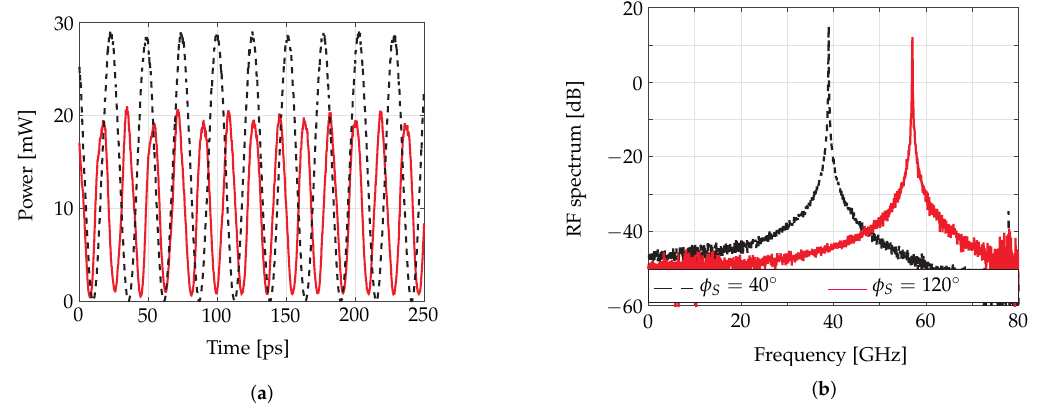
Figure 7. Two examples of sinusoidal the self-pulsation (SP) operation in Region (A) of Figure6a for I S = I M = 30mA for two different values of φ S : ( a ) the time domain signals and ( b ) the corresponding RF spectrum. The dashed black line ( φ s = 40 ◦ ) is used for the minimum value of the PPR frequency f PPR 39GHz, while the continuous red line ( φ s = 120 ◦ ) is used for the case f PPR ≈